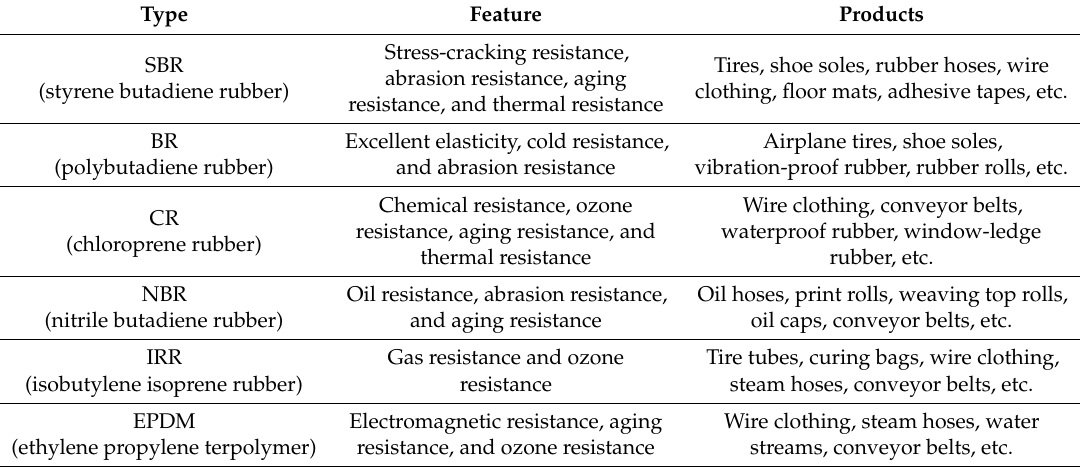
Table 1. Types of synthetic